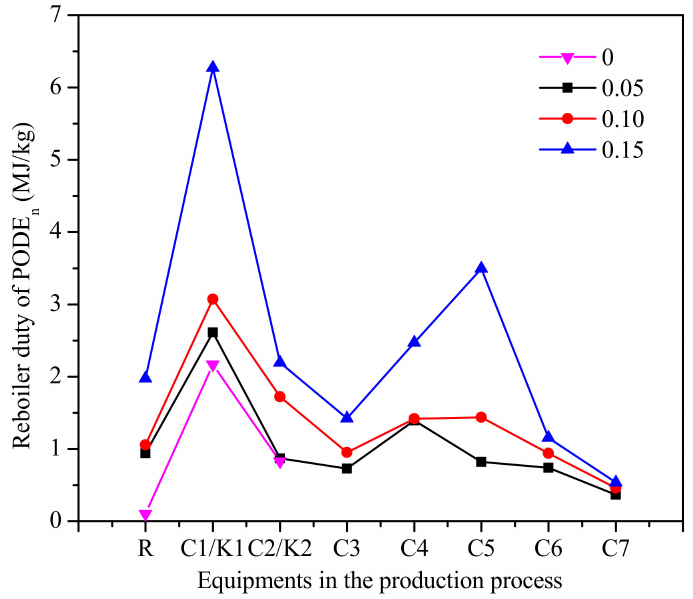
Figure 11. The reboiler duty of each equipment in the process of PODE n . (Methylal / CH 2 O mass ratio 2:1).